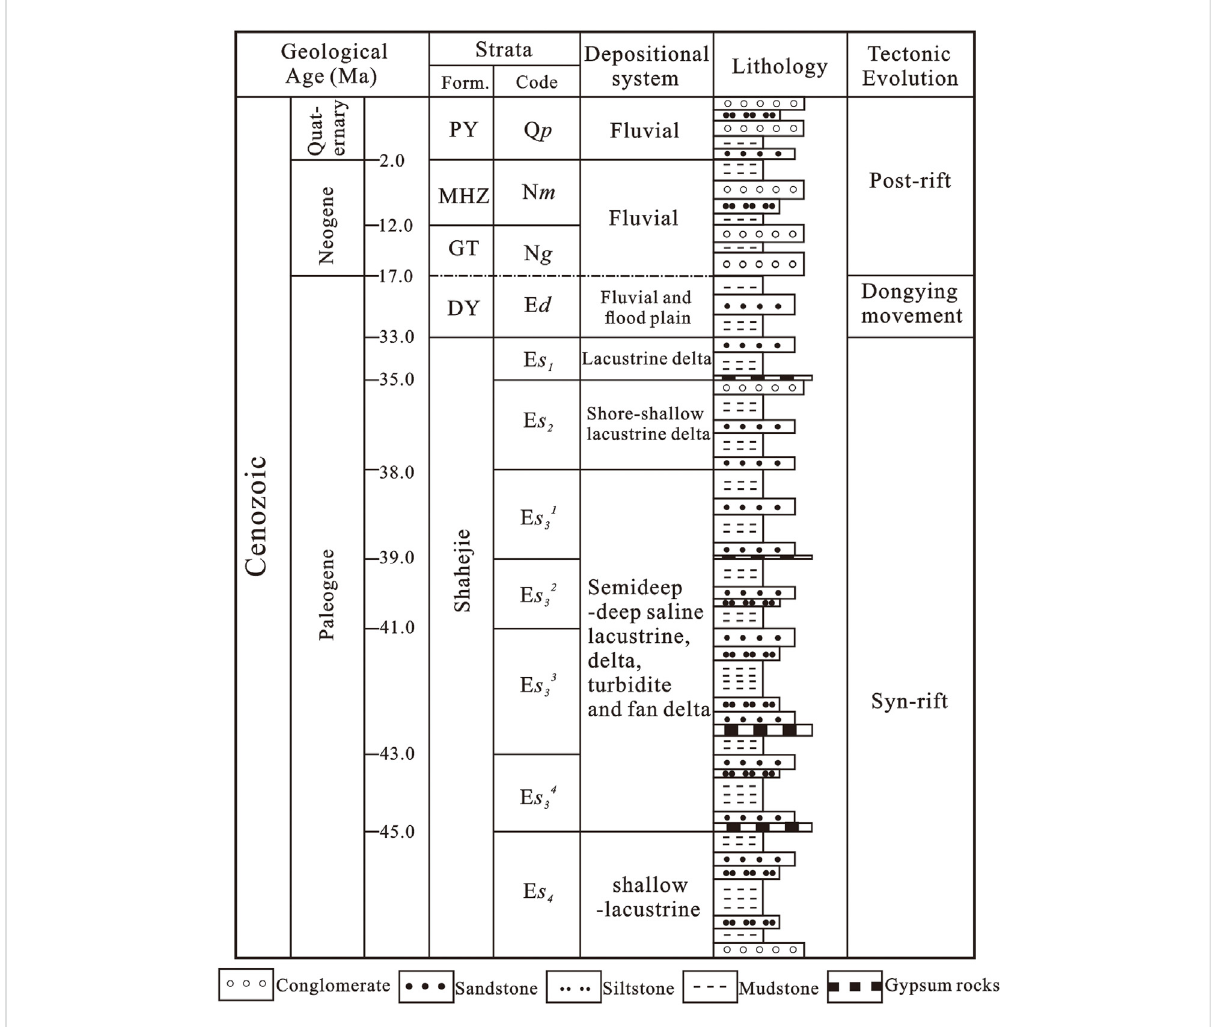
FIGURE 2 CenozoicstratigraphiccolumnofDongpu Sag.PY:Ping YuanFormation; MHZ:MingHuaZhenFormation; GT:GuanTaoFormation; DY:Dong Ying